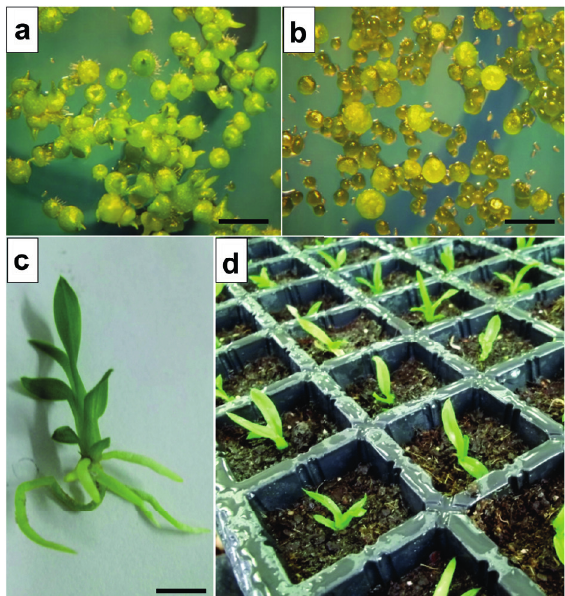
Figure 1 - Grandiphyllum divaricatum seeds germination. Protocorms after 90 days of inoculation: a - in WPM b- in MS culture medium Bar: 2 mm. c - Seedling developed on WPM medium, supplemented with activated charcoal; d- Acclimatized plants. Bar: 2 mm. Cell size in tray: 3